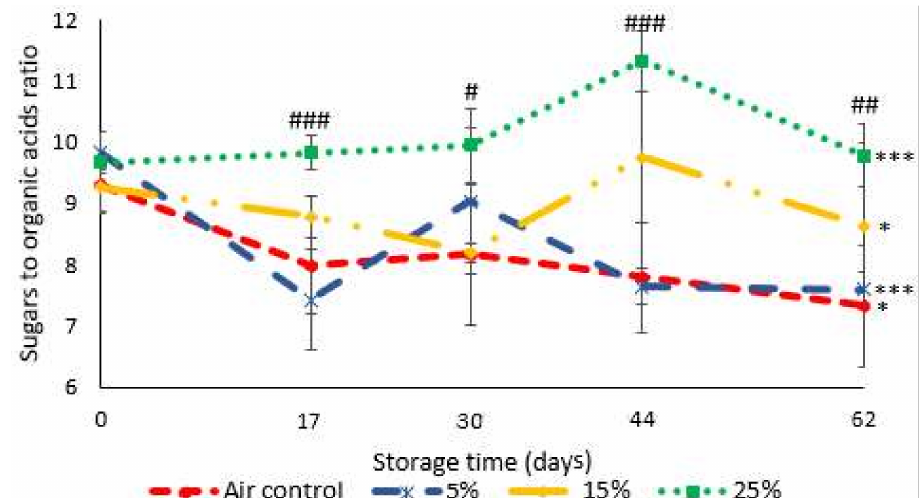
Figure 4. Blueberry ‘Liberty’ fruit sugars-to-organic acid ratio under the air control and controlled atmospheres (5% CO 2 , 5% O 2 , 90% N 2 (5%); 15% CO 2 , 5% O 2 , 80% N 2 (15%); and 25% CO 2 , 5% O 2 , 70% N 2 (25%)) for different storage times. *, p < 0.05; ***, p < 0.001 (versus storage = 0, within each storage condition). #, p < 0.05; ##, p < 0.01; ###, p < 0.001 (versus air storage, for each storage